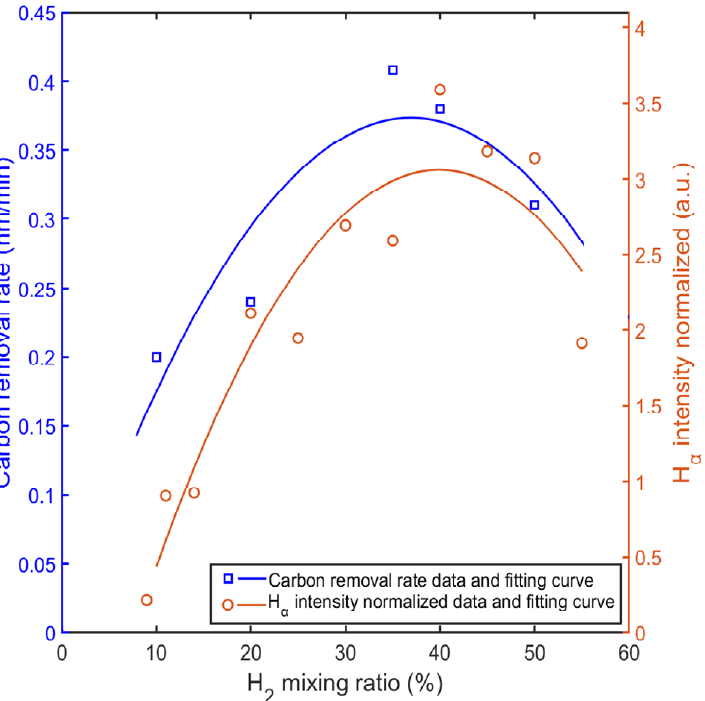
Figure 12. Comparison between normalized intensity of H α and carbon removal rate with different mixing ratios.